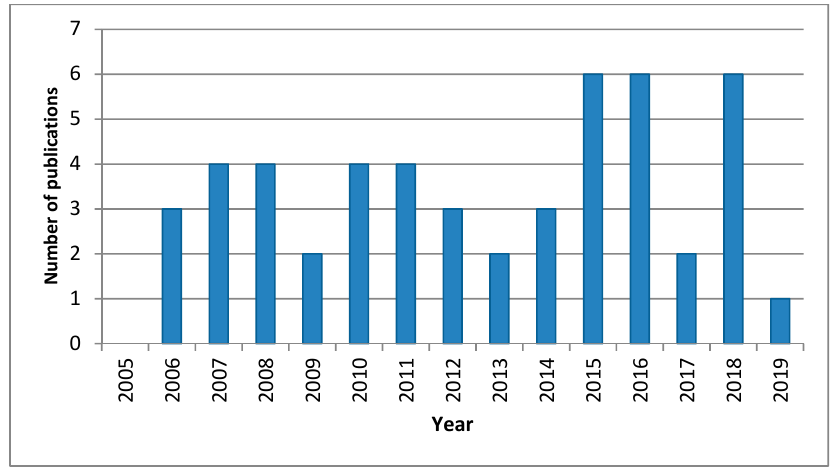
Figure 2. Number of annual publications, from 2005 to 2019.